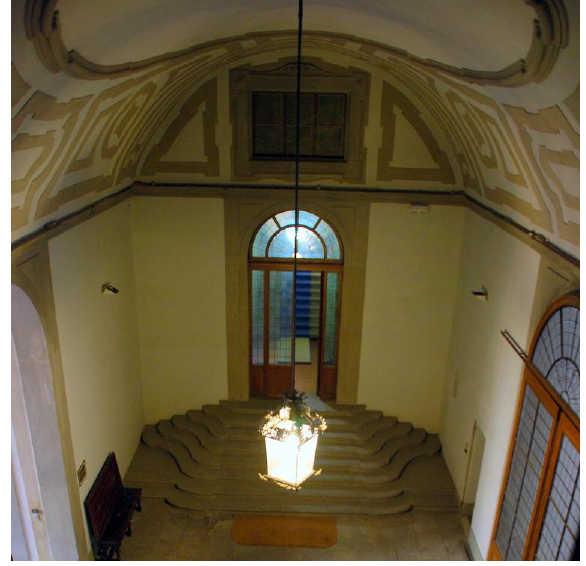
Figure 2. The vault of the central room